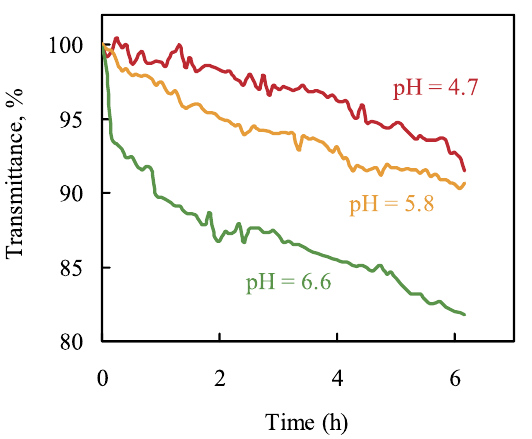
Figure 4. Effect of the pH modifier on the scale formation monitored by the fiber optic sensor. Exposed core length: 24 cm; wavelength: 600 nm; pH values: 4.7 (100 mg/L, red line), 5.8 (10 mg/L, yellow line), and 6.6 (0 mg/L, green